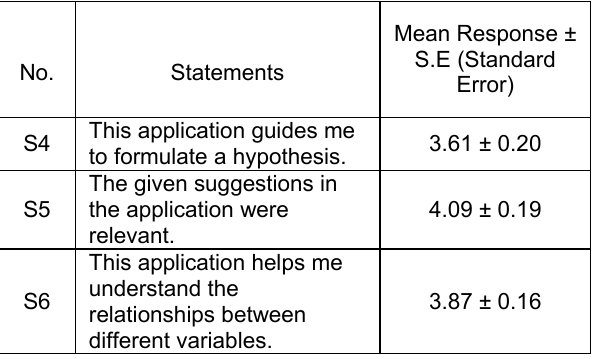
Table 3. Responses related to the hypothesis generation aspect.